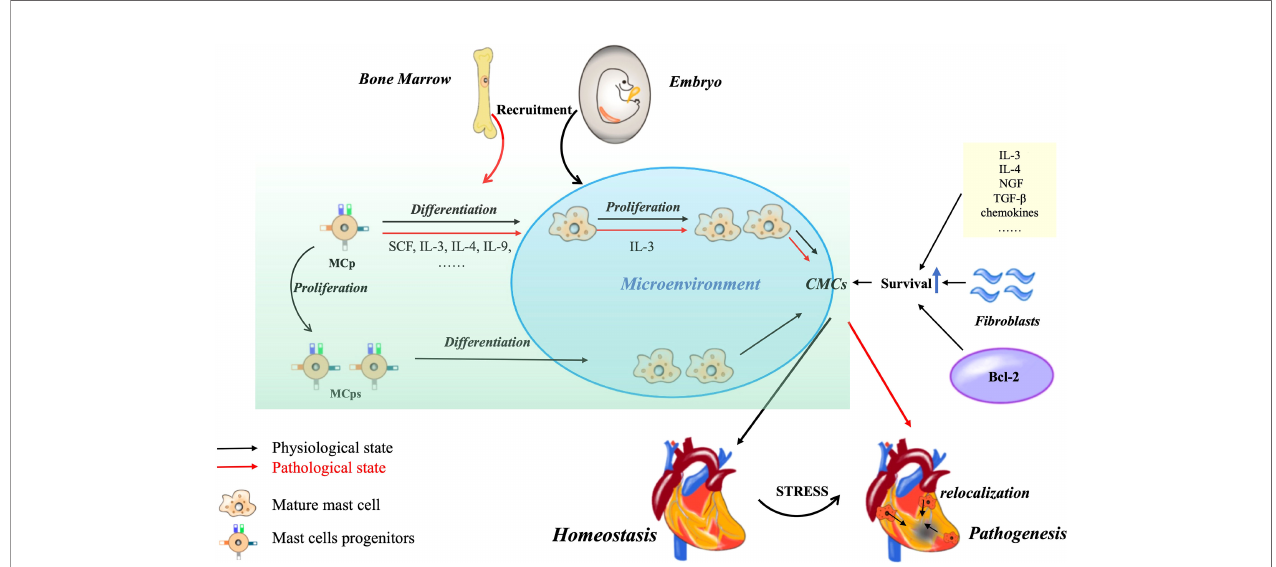
FIGURE 1 | CMCs origin, development and survival. Most of CMCs in the physiological state of the heart come from embryonic stage, and only a small part come from bone marrow. The increase of CMCs can be differentiated from MCp or through self-proliferation. Under pathological conditions, MCps are recruited from bone marrow. The density can also be increased by the relocation of CMCs in non-injured sites. In addition, some cytokine chemokines, cardiac fi broblast derived growth factors and Bcl-2 family can promote the survival of